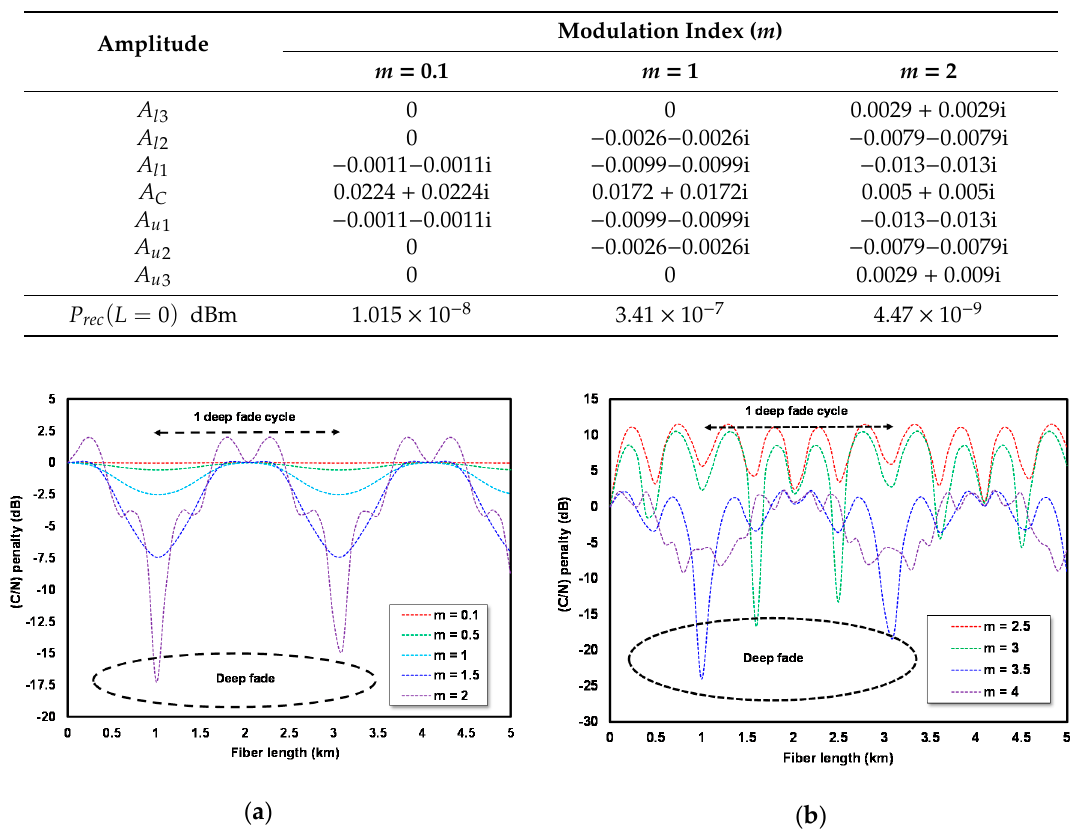
Figure 4. C / N penalty of the RoF link with OSSB modulation for ( a ) m ≤ 2 and ( b ) m > 2. Table 2. Comparison value of the ∆ C/N Penalty and DF between the ODSB and OSSB Modulation.